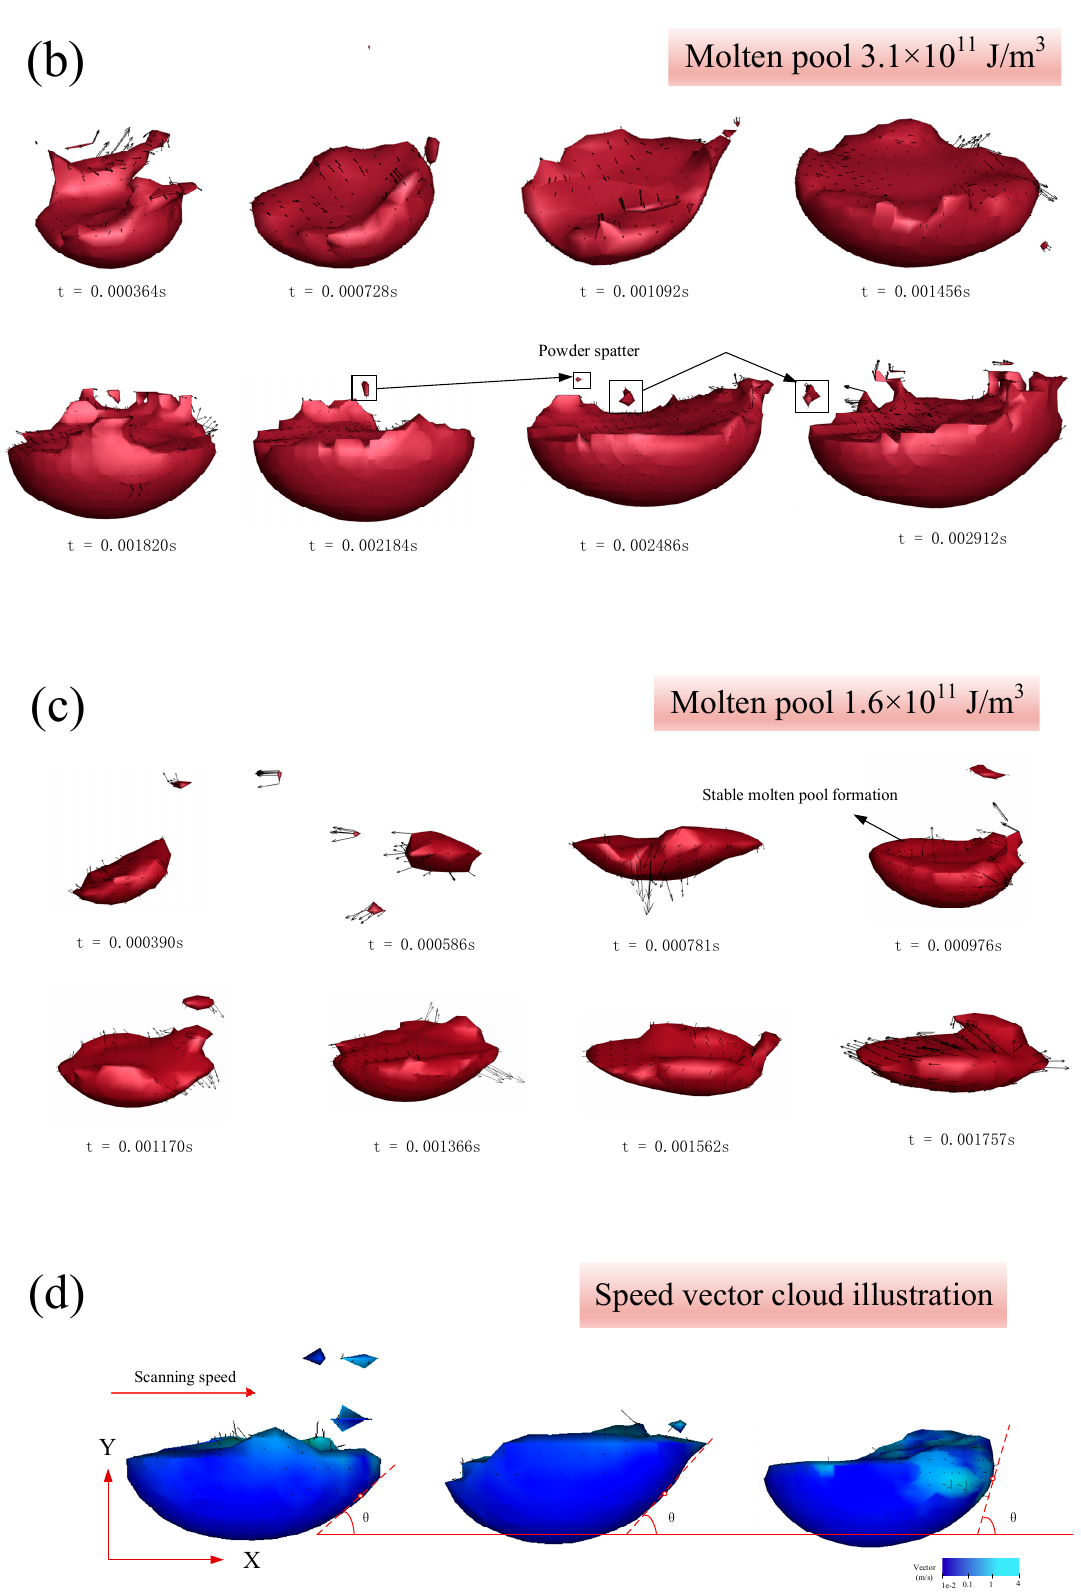
Figure 8. Macro view of the molten pool. ( a ) 4.0 × 10 11 J/m 3 ; ( b ) 3.1 × 10 11 J/m 3 ; ( c ) 1.6 × 10 11 J/m 3 ; and ( d ) speed vector cloud illustration of 4.0 × 10 11 J/m 3 .